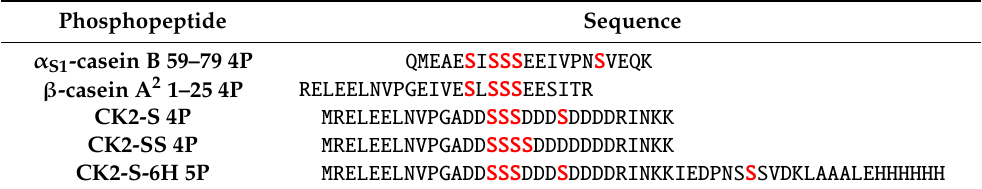
Table 3. Sequences of tryptic phosphopeptides from bovine β - and α S1 -caseins, two recombinant, tryptic phosphopeptides, based on β -casein (CK2-S and CK2-SS) and a soluble whole construct based on the N-terminal region of β -casein with a C-terminal 6-His tag (CK2-S-6H) [40,112]. Phosphorylated residues are shown in boldface